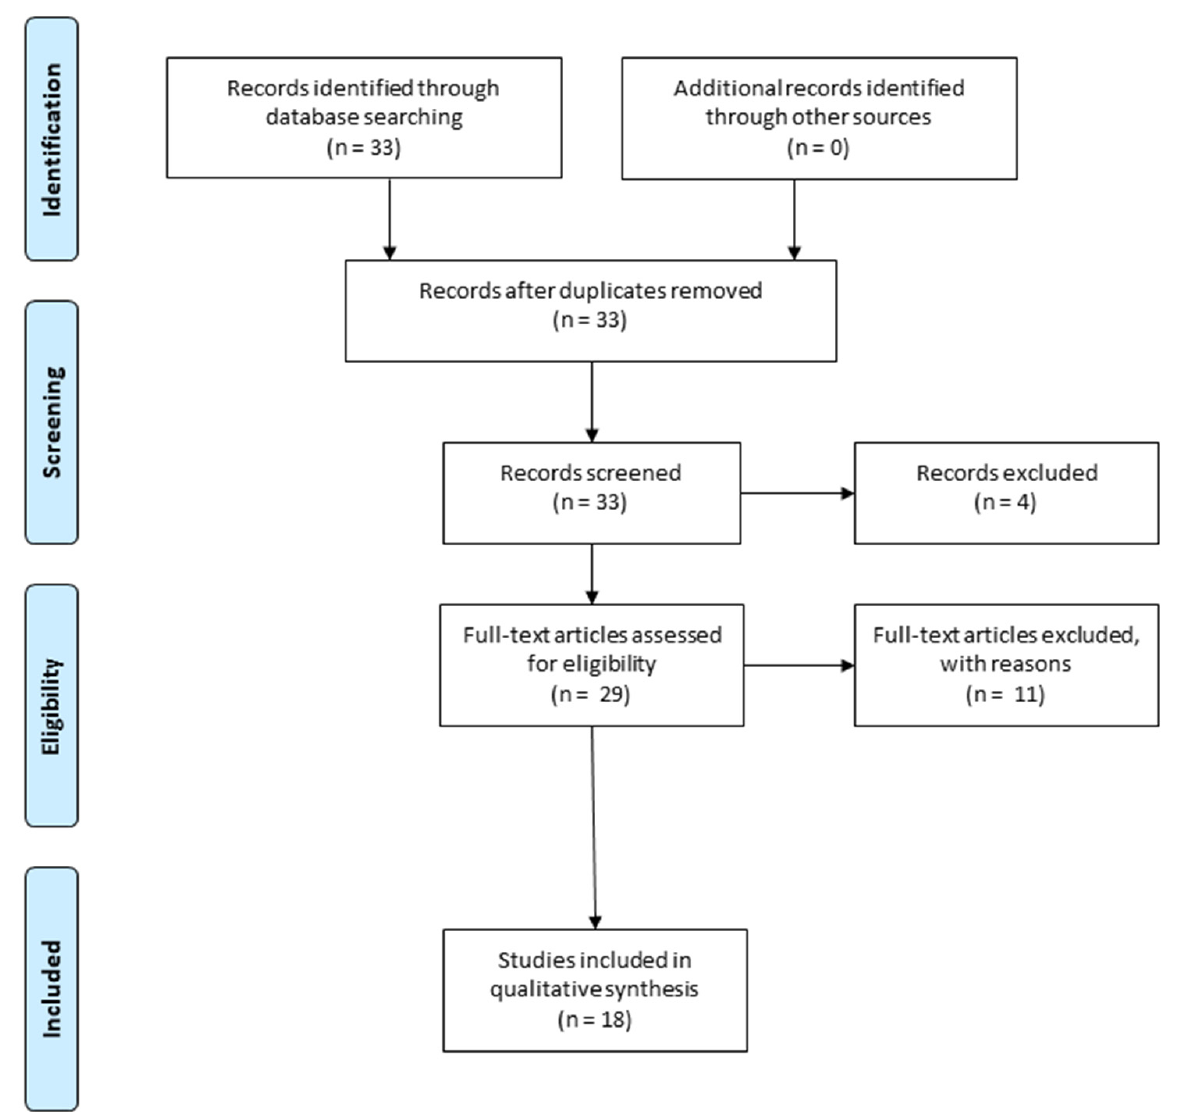
Figure 1. Prisma flow diagram illustrating the selection methodology of the preclinical studies used for the writing of the review. There were experimental studies considered that evaluate quercetin’s functional properties in depressive-like behaviors, highlighting biochemical and molecular mechanisms underlying its beneficial effects (The PRISMA Statement was published in: [31]).